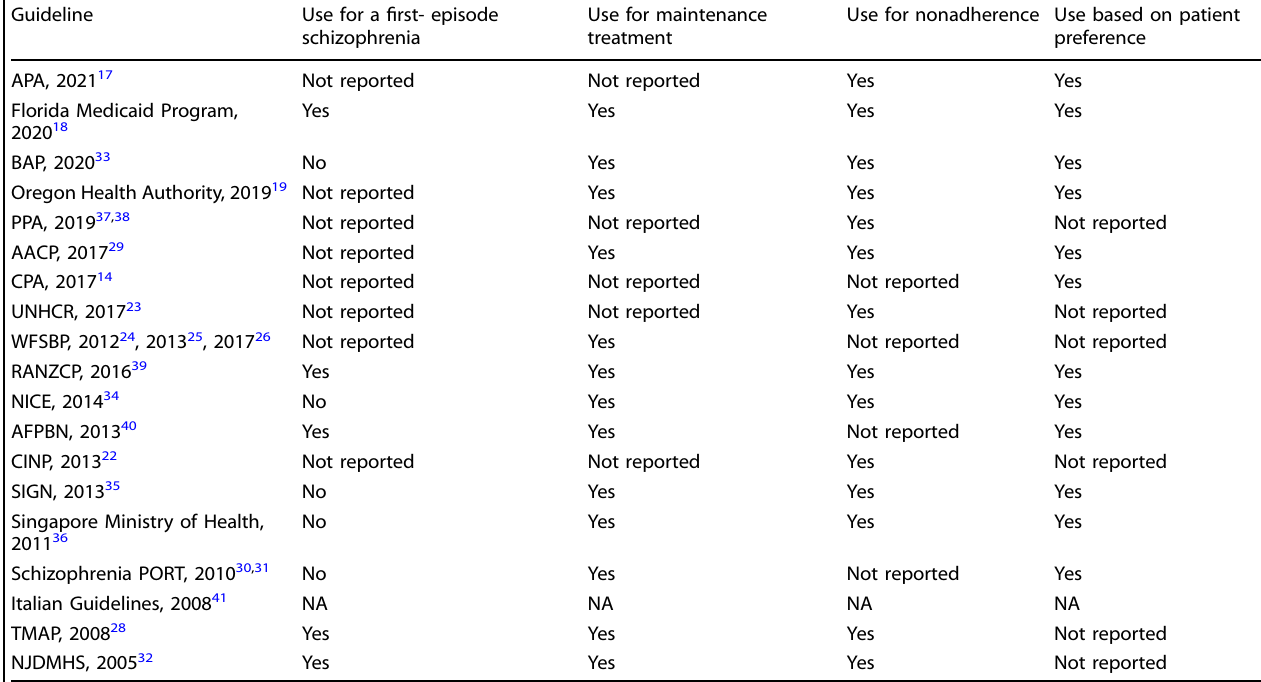
Table 3. Recommendations for LAI antipsychotics in the treatment of schizophrenia.